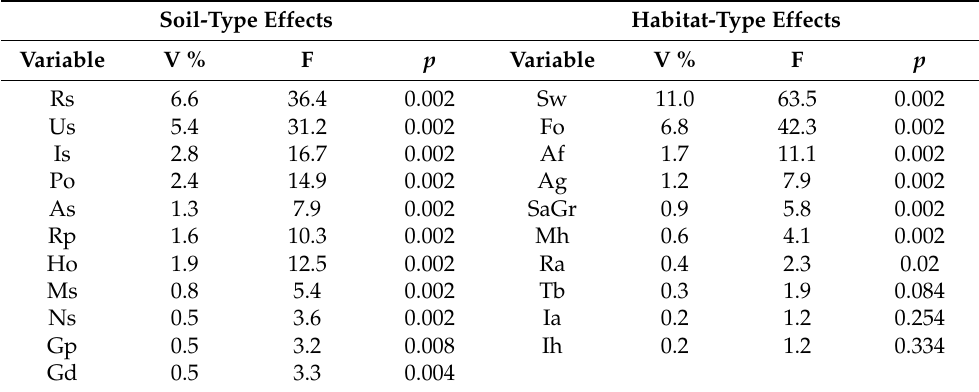
Table 1. Results of forward selection and Monte Carlo permutation test demonstrating relative importance and statistical significance of soil types and habitat types in IAS distribution pattern.